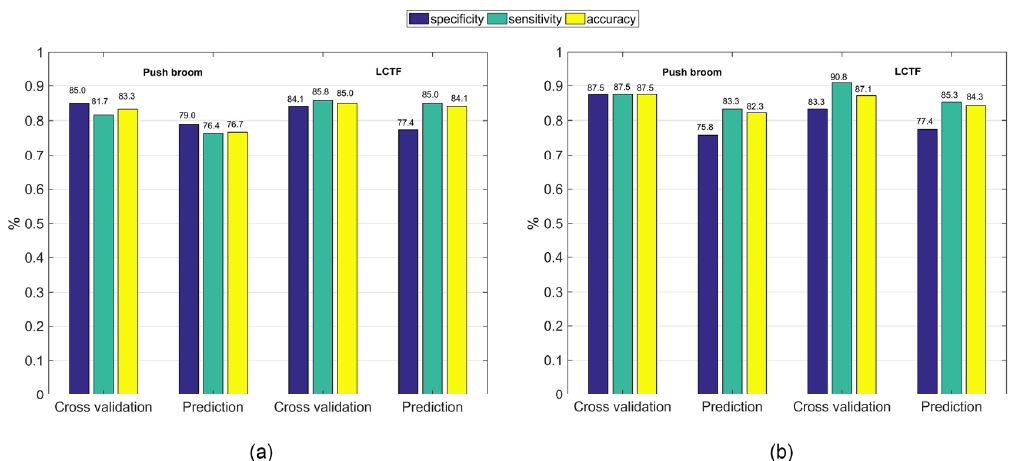
Figure 4. Classification results of ( a ) partial least squares discriminant analysis (PLS-DA) and ( b ) support vector machine (SVM) models for distinguishing between bruised and healthy samples based on the mean reflectance from push broom based and LCTF based